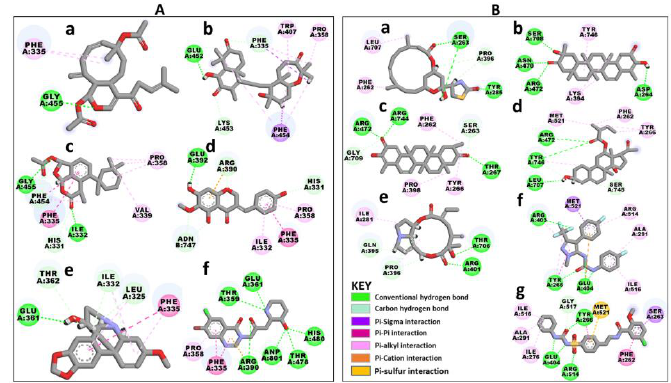
Figure 3. Binding modes of selected (A) orthosteric and (B) allosteric hits. ( A ) 2D representation of (a) SANC152; (b) SANC235; (c) SANC236; (d) SANC244; (e) SANC318; (f) halofuginone (PDB ID: 4YDG) [37] and their binding modes with PfProRS active site. ( B ) 2D representation of (a) SANC184; (b) SANC257; (c) SANC264; (d) SANC456; (e) SANC622 (f) TCMDC-124506 (PDB ID: 4WI1); (g) glyburide